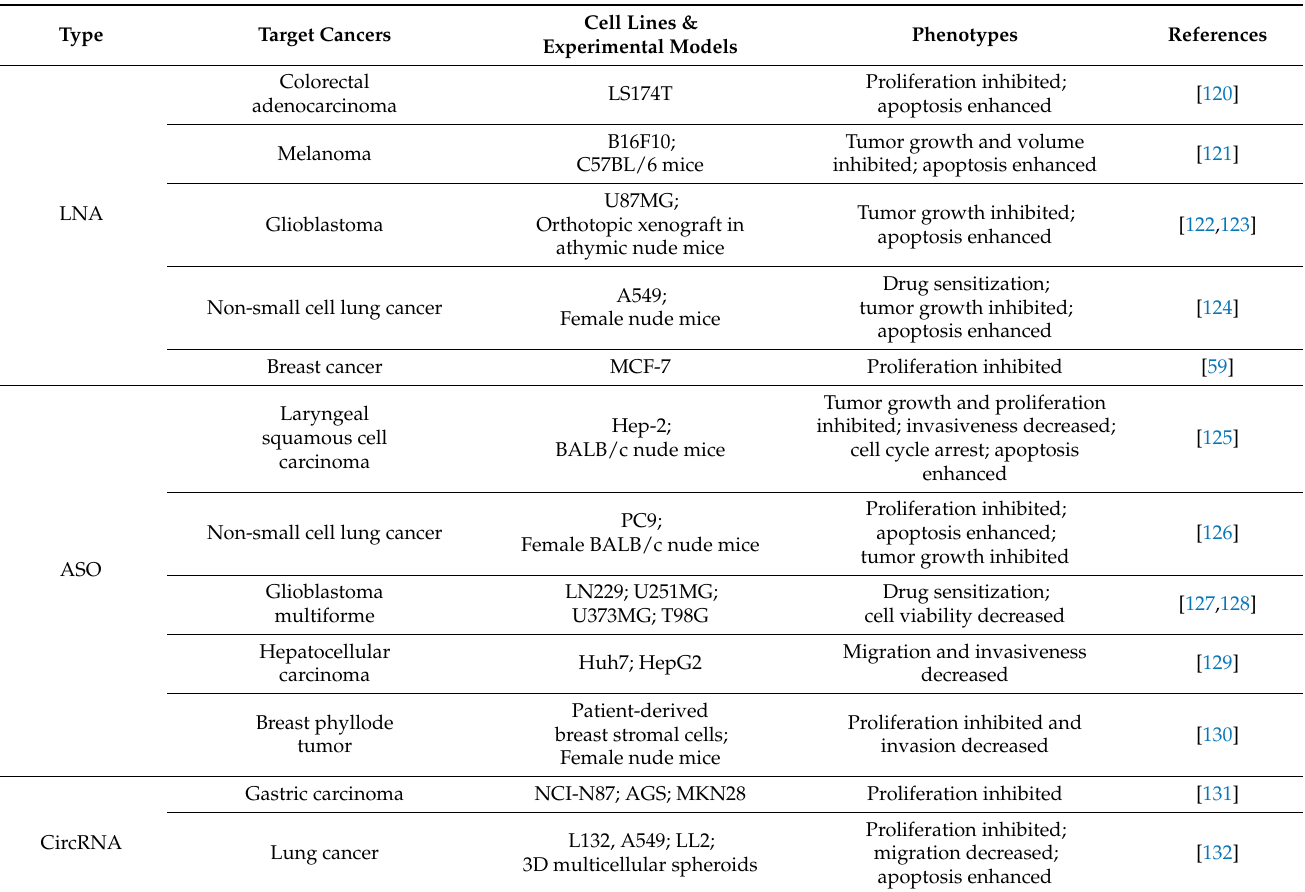
Table 2. Therapeutic approaches of miR-21 targeting in